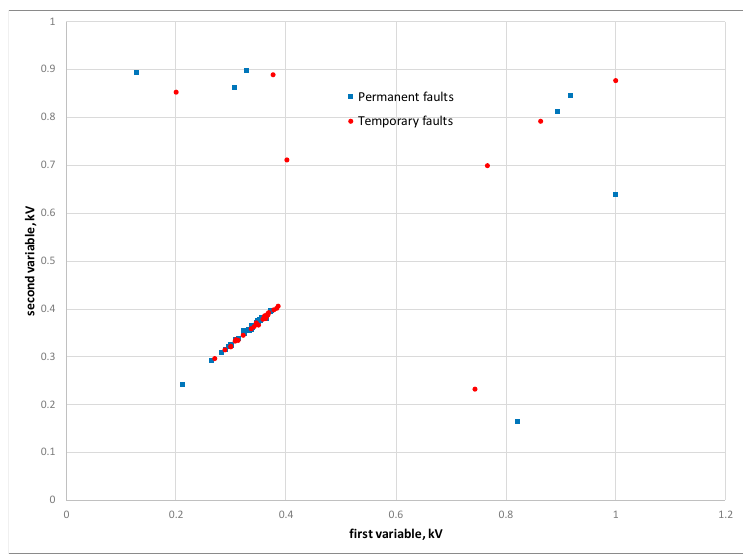
Figure 11. Permanent and temporary faults projected on the first two variables of the original faults’ matrix.